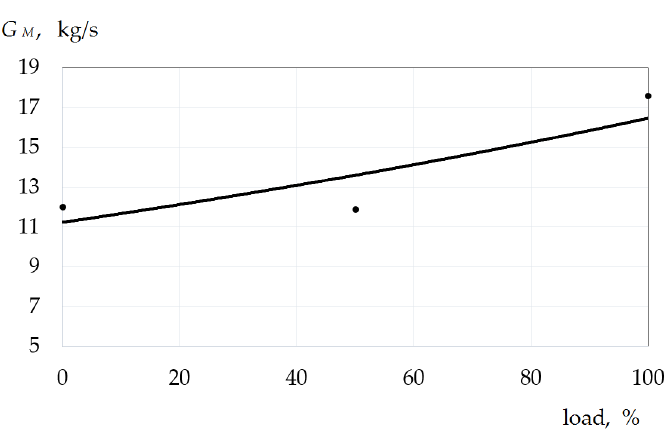
Figure 15. Dependence of mixing air flow rate for all combustion chambers on the load value.